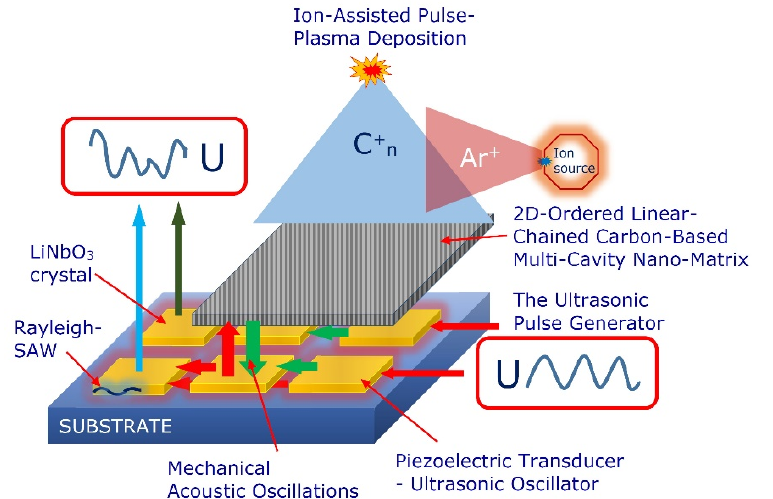
Figure 9. Schematic representation of using the direct and inverse piezoelectric effect at the nanomatrix ion-stimulated pulse-plasma deposition.